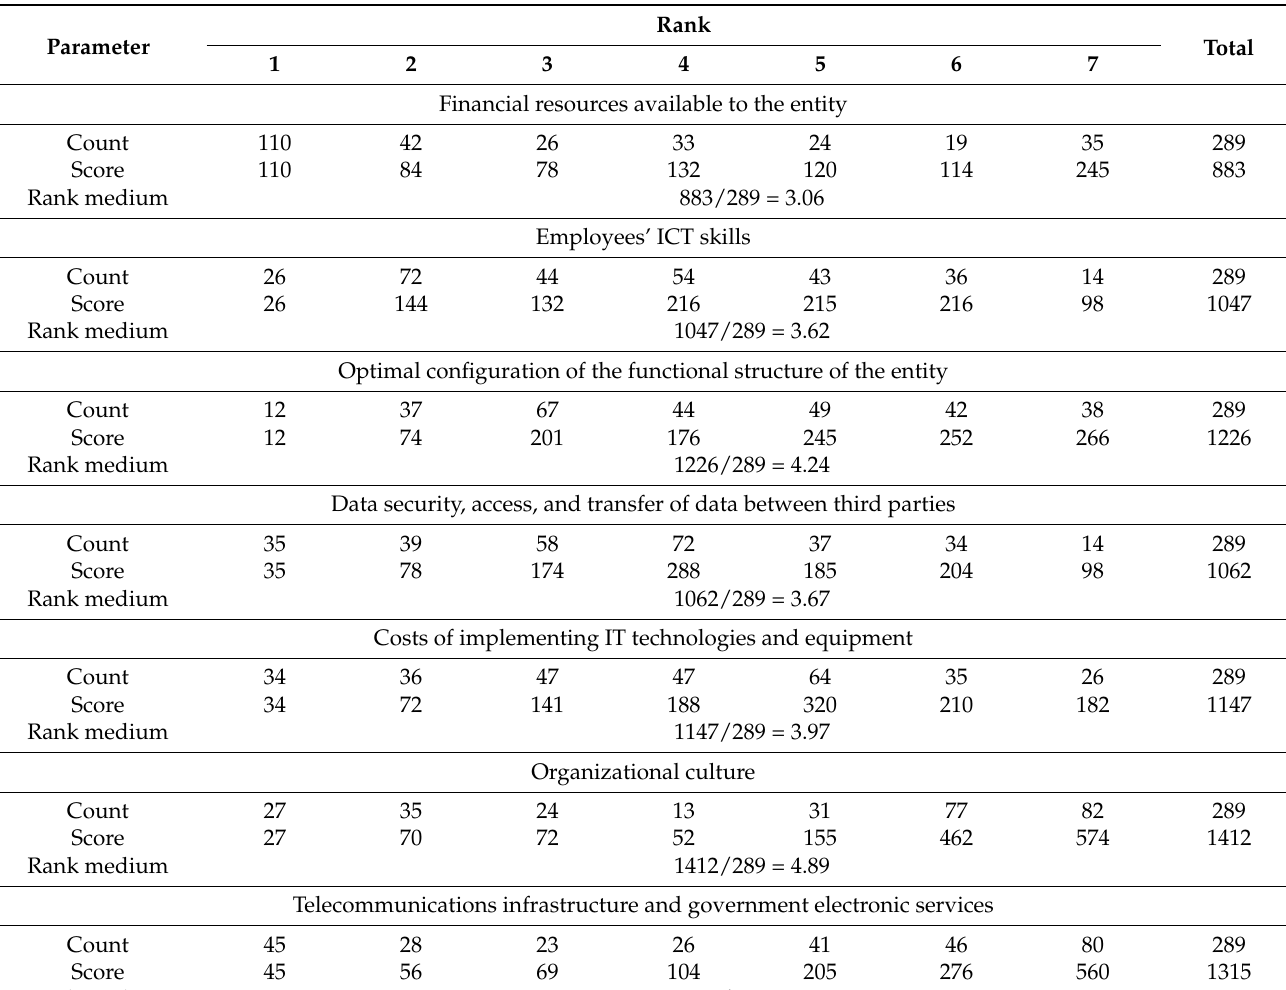
Table 4. Hierarchy of factors influencing the digitization